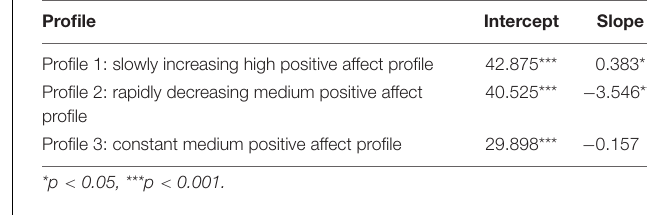
TABLE 7 | Multinomial logistic regression predicting negative affect trajectory class membership (Odds ratios).